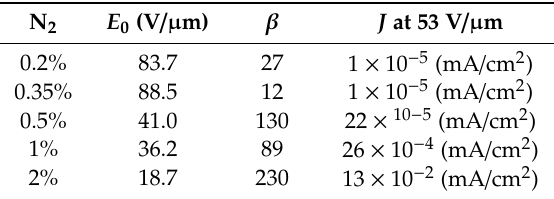
Table 2. Field electron emission (FEE) properties of P and N co-doped NCD films with varying N 2 concentrations.